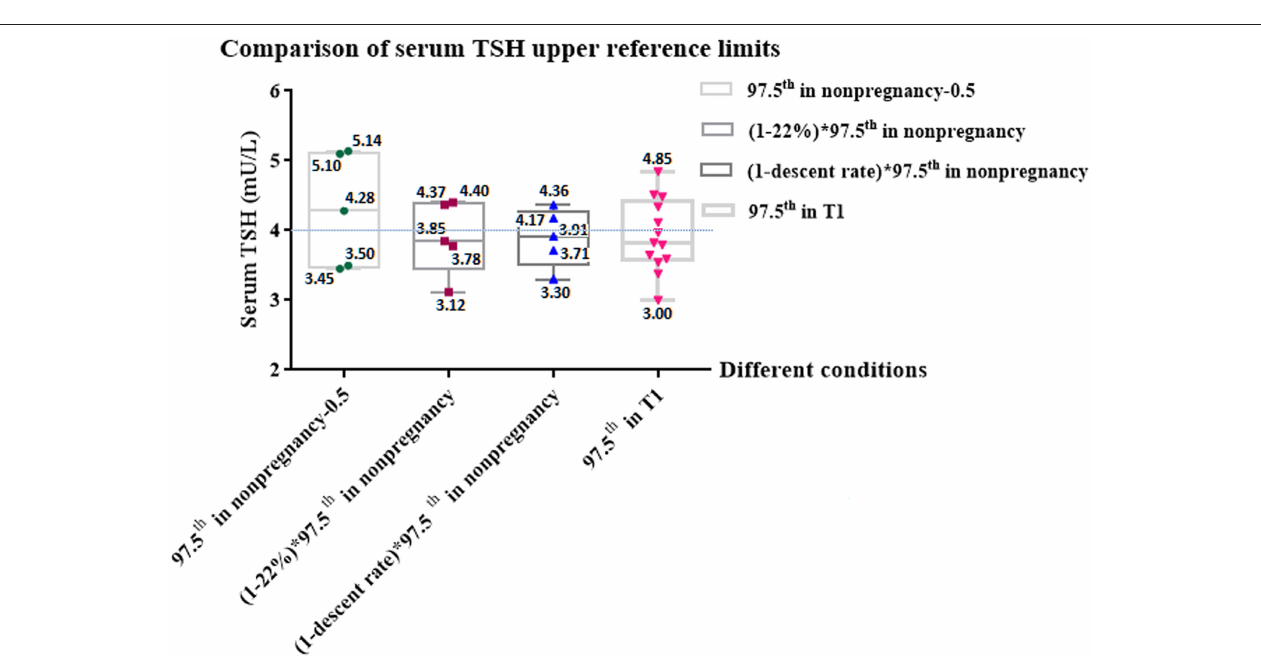
FIGURE 4 | Comparison of serum TSH upper reference limits under different conditions. Figure shows the comparison among serum TSH upper reference limits acquired in different conditions and shows the gaps between the limits and 4.0 mU/L. T1, the first trimester of pregnancy; 97.5th, the upper reference limit; TSH, thyroid stimulating hormone; 97.5th in non-pregnancy, the normal TSH upper limits provided by 5 kinds of manufacturers (Roche, Bayer, Abbott, DPC, and Beckman); 97.5th in T1, The real serum TSH upper limits during early pregnancy provided by 11 enrolled studies. 97.5th in non-pregnancy – 0.5, We subtracted 0.5 mU/L from the normal TSH upper limits provided by 5 kinds of manufacturers (Roche, Bayer, Abbott, DPC, and Beckman), according to 2017 ATA guidelines’ recommendation that 4.0 mU/L represents a reduction in the non-pregnant TSH upper reference limit of ∼ 0.5 mU/L (5); (1 – 22%) × 97.5th in non-pregnancy, In our